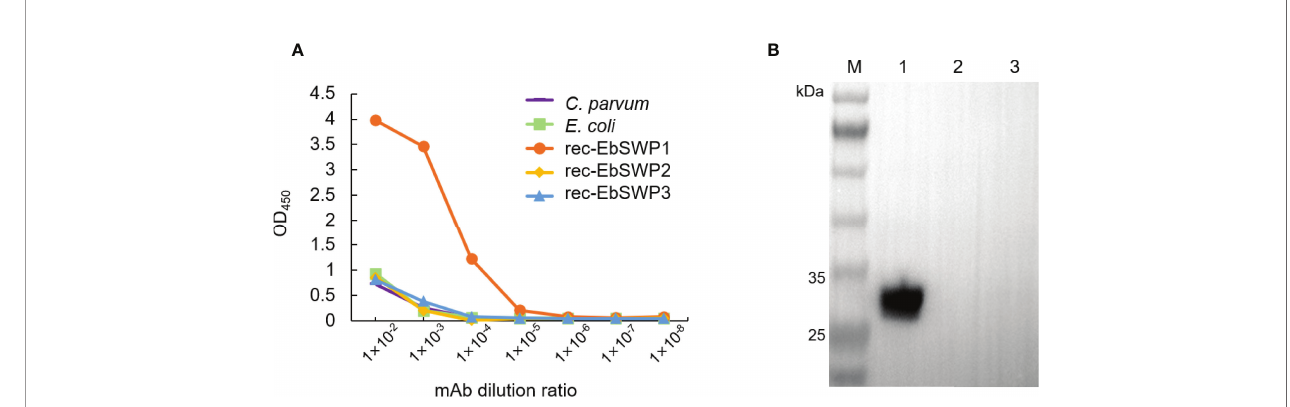
FIGURE 4 | Speci fi city of monoclonal antibody of EbSWP1. (A) ELISA analysis of related antigens with anti-EbSWP1 mAb. The x-axis and y-axis are dilutions of the puri fi ed mAb and absorbance reading of the assay, respectively. (B) Western blot analysis of recombinant EbSWPs with anti-EbSWP1 mAb. Lane M: protein molecular weight marker; lane 1: EbSWP1; lane 2: EbSWP2; lane 3: